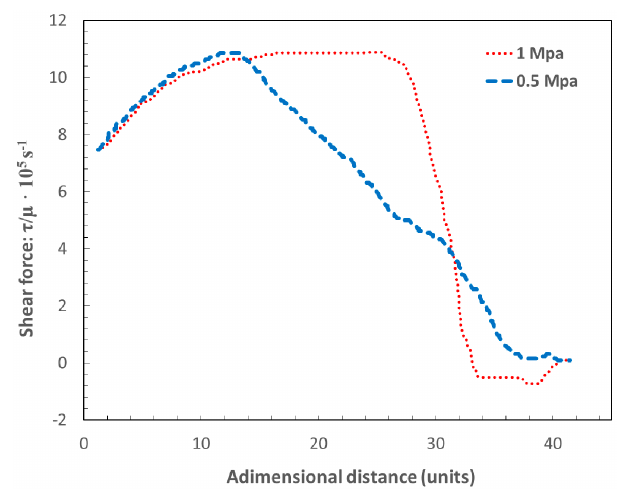
Figure 10. Shear force distribution acting along the cutting front (when using a conical nozzle). A clear drop is noted after the boundary layer separation (estimated shear force in arbitrary units acting on the centerline of the cutting front for p = 1 MPa and p = 0.5 MPa). Adapted with permission from [49];